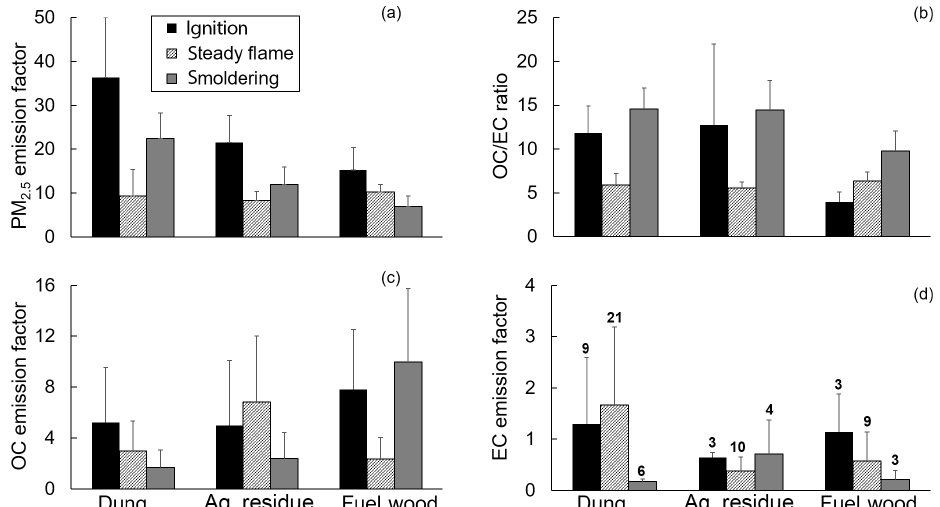
Figure 3. Fuel-wise average values of (a) PM 2 . 5 emissions factors, (b) OC / EC ratios, (c) OC emissions factors, and (d) EC emissions factors, categorized by observed combustion phases. All emissions factors are expressed in grams of pollutant per kilogram of fuel burnt. One-sided error bars are shown to denote 1 standard deviation from the mean. The numbers above the error bars in panel (d) indicate the number of samples for each fuel and combustion